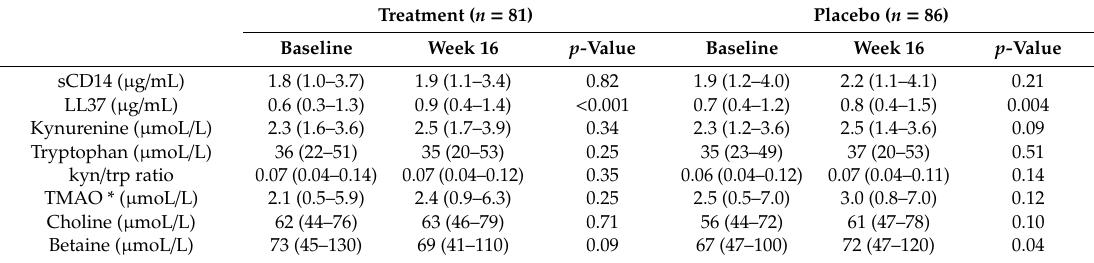
Table 2. Treatment e ff ect on metabolites and inflammation in antiretroviral therapy (ART)-naïve HIV-1. Treatment ( n =